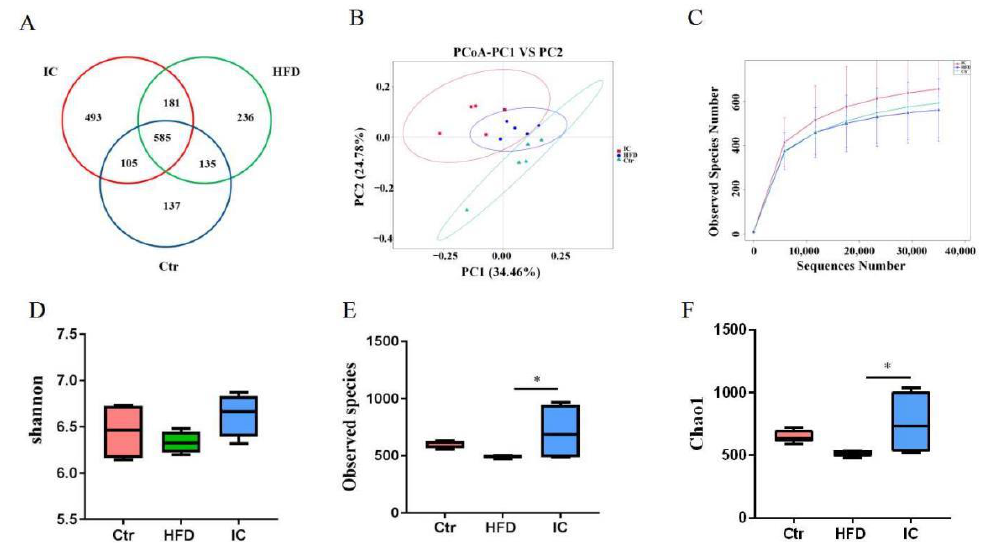
Figure 3. α and β diversity in the fecal samples from the three experimental groups. ( A ). Venn diagram showing the shared and unique OTUs across three experimental groups. ( B ). Principal coordinate analysis (PCoA) ordination plot for the three experimental groups. ( C ). Rarefaction curves showing the average observed species number for three groups. ( D ). Shannon index diversity in the experimental groups. ( E ). Observed species index diversity in the experimental groups. ( F ). Chao1 indices diversity in the experimental groups. * p < 0.05, versus the HFD group.